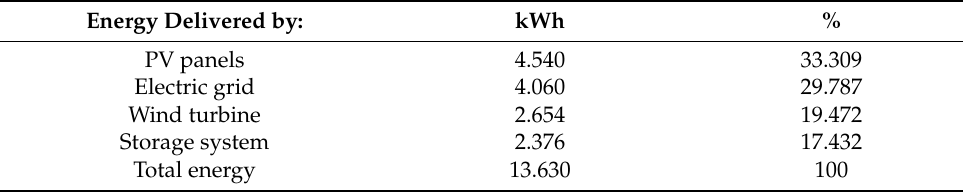
Table 2. The amount of energy used for consumption—first scenario. Energy Delivered by: kWh